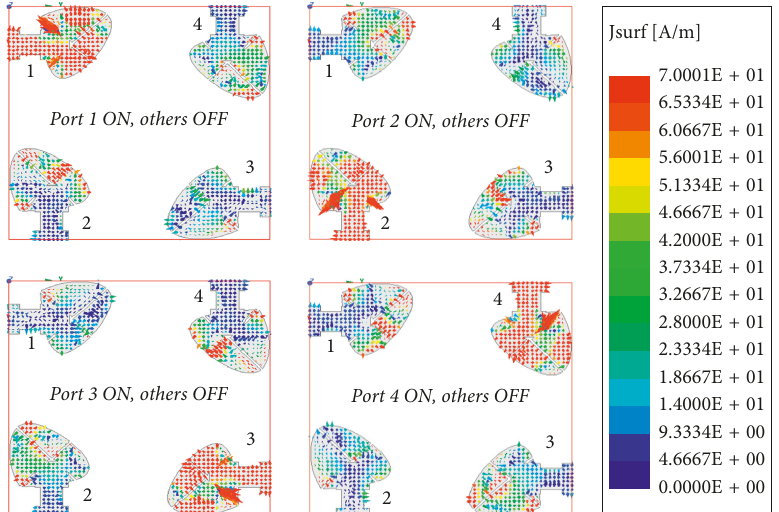
Figure 9: Simulated surface current distribution on the MIMO configuration. (a) PORT 1 ON, others OFF. (b) PORT 2 ON, others OFF. (c) PORT 3 ON, others OFF. (d) PORT 4 ON, others OFF.